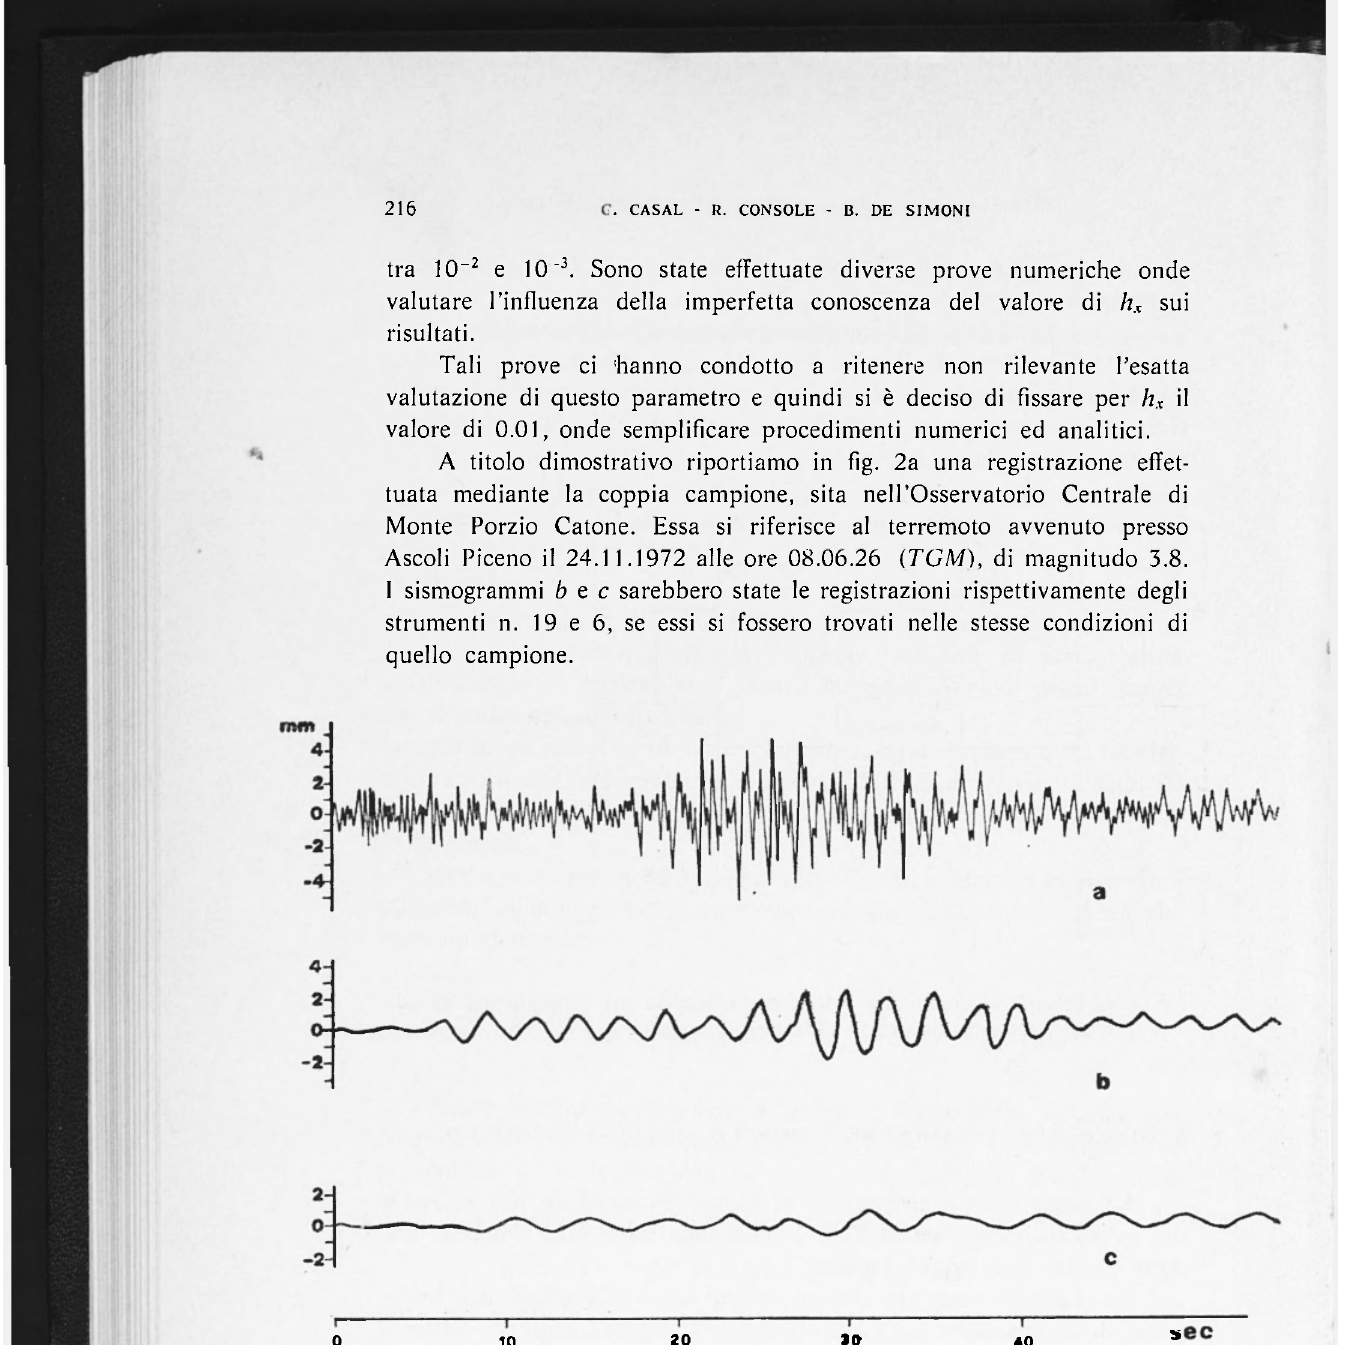
Fig. 2 — Confronto fra la registrazione ottenuta con il sismografo Wood-Andcrson e quelle ricavate analiticamente per gli strumenti riferiti nel testo con il numero 19 e b. II terremoto è quello di Ascoli Piceno del 24.11.72, 08'' 06"' 26 5 , con M, = 3.8 e A = 126